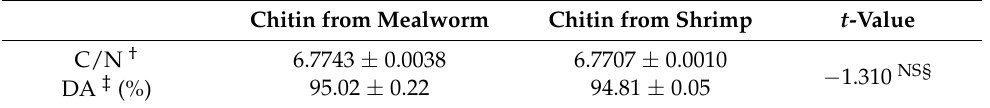
Table 3. C/N ratio determined based on energy dispersive X-ray spectroscopy (EDS) data and the predicted degree of acetylation for chitin or degree of deacetylation for chitosan. Chitin from